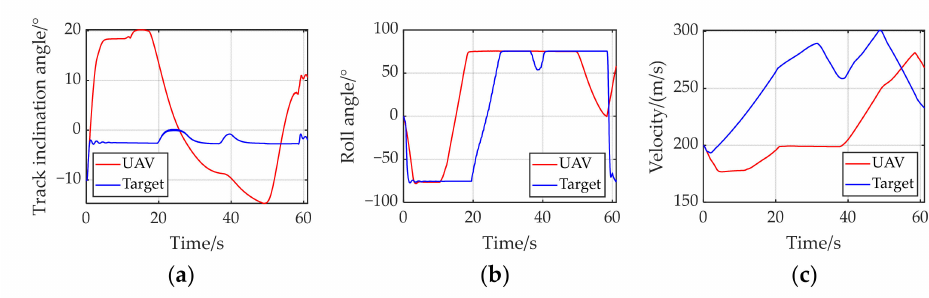
Figure 12. Flight status of the UAV in case 2: ( a ) track inclination angle, ( b ) roll angle, ( c )